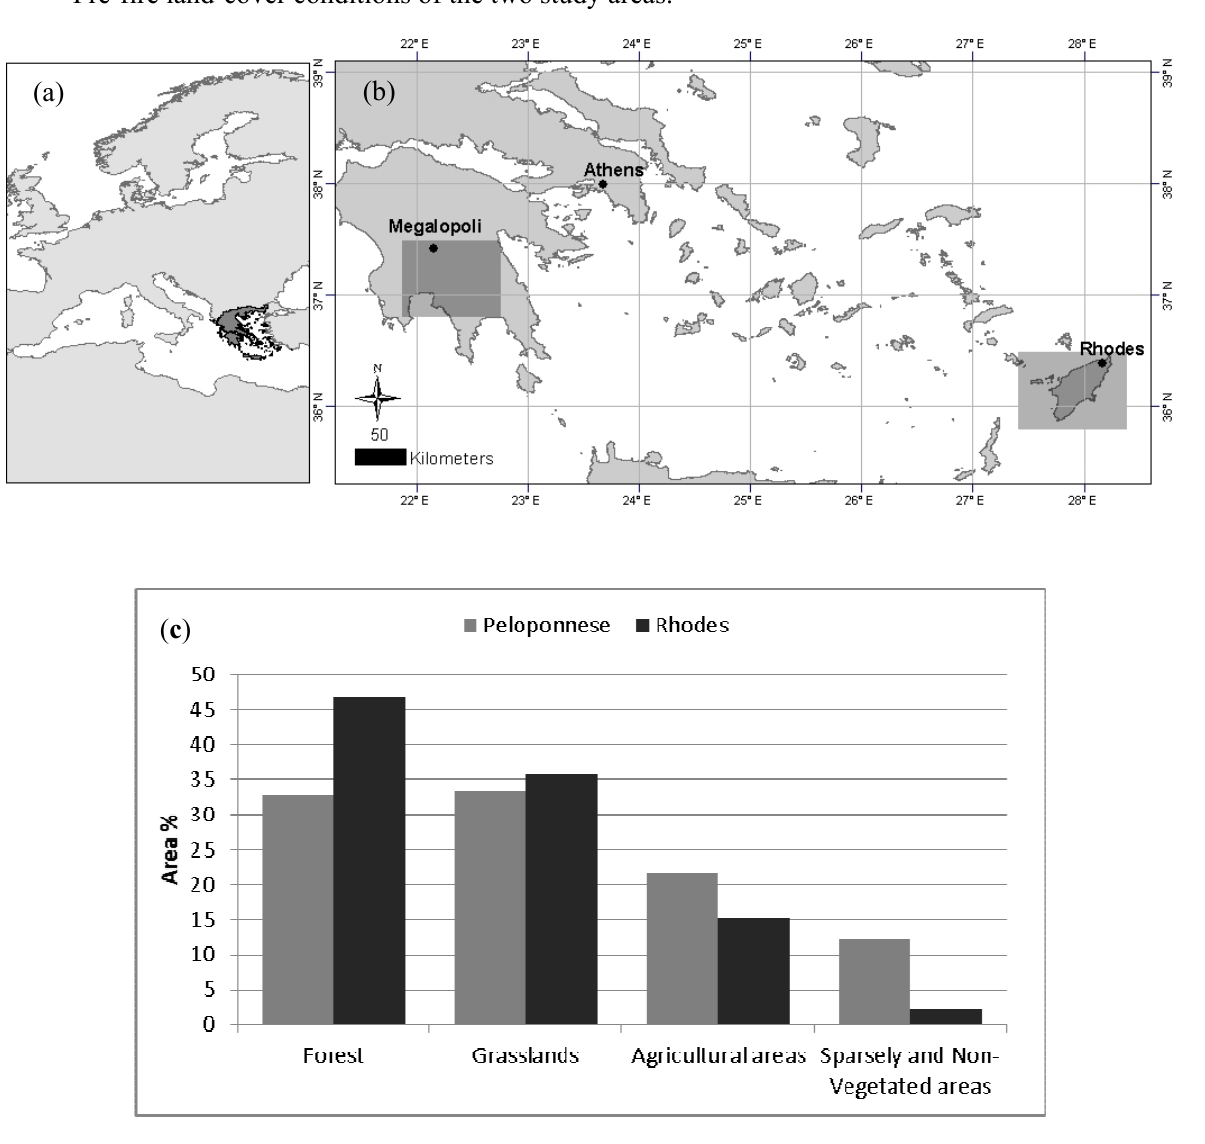
Figure 1. ( a ) Greece highlighted (darker grey) in the map of Europe. ( b ) Location of the